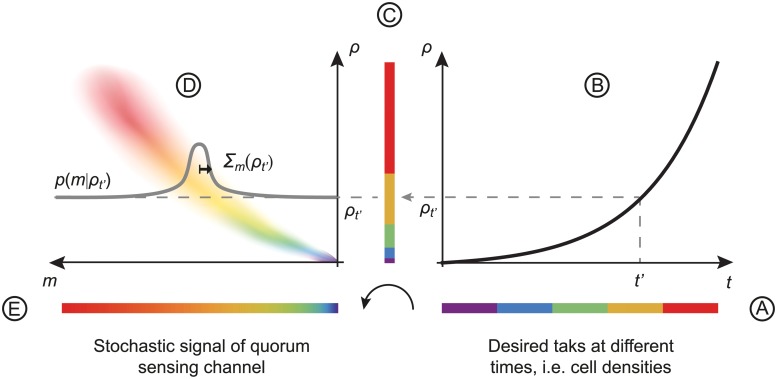
Quorum-sensing information channel.
A. In this illustration, bacteria engage sequentially in five fictitious collective tasks, represented by five colors, that are homogeneously distributed in time. B. During the growth of a colony, the increasing cell density drives the quorum-sensing system. C. To perform the desired tasks, bacteria need to resolve the five cell-density stages, whose probability is shaped by bacterial growth. D. At fixed cell density, individual bacteria exhibit fluctuating levels of MPs, with mean m¯(ρ) and variance Σm2(ρ). E. The smallest difference in cell density that a bacterium can resolve by reading out its fluctuating MP abundance specifies the resolution of the channel, defined as δ
ρ = Σm(ρ)/m′(ρ). Thus, the information available to individual bacteria via quorum sensing depends both on the cell density dynamics and the channel resolution.